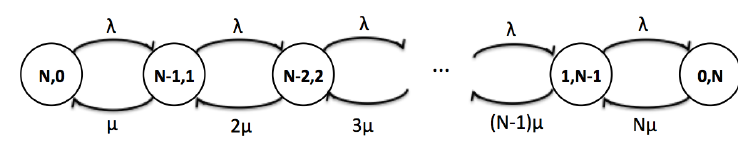
Figure 7. Markov chain for the maximum case with asynchronous